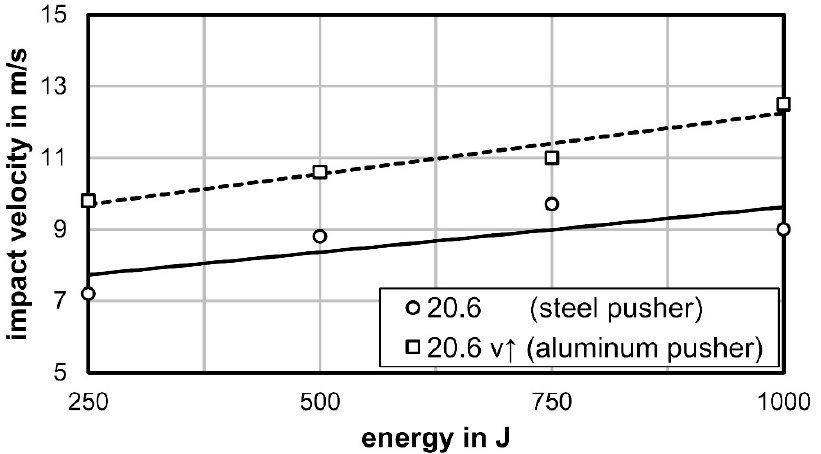
Figure 6. Evaluation of the impact velocity for a relative clearance of 10% with varying impact energies and different pushers.